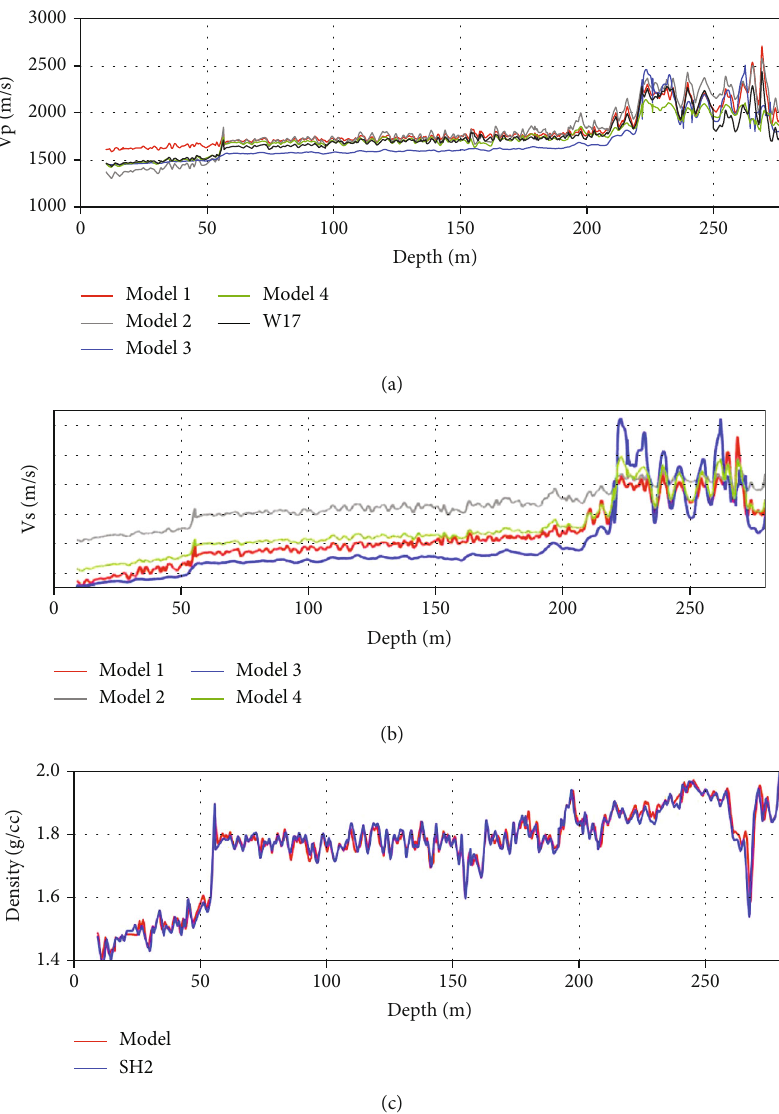
Figure 12: Comparison of V and V at well W17 based on di ff erent models (original boreholes): (a) V p s di ff erent models, and (c) density of Model and SH2. Model 1 is a pore- fi lling model, Model 2 is a thermodynamic elastic model, Model 3 is a particle cementation model, SH2 is a measured drilling curve, and Model 4 is a modi fi ed model; data 1 is a measured drilling curve, and data 2 is the estimated